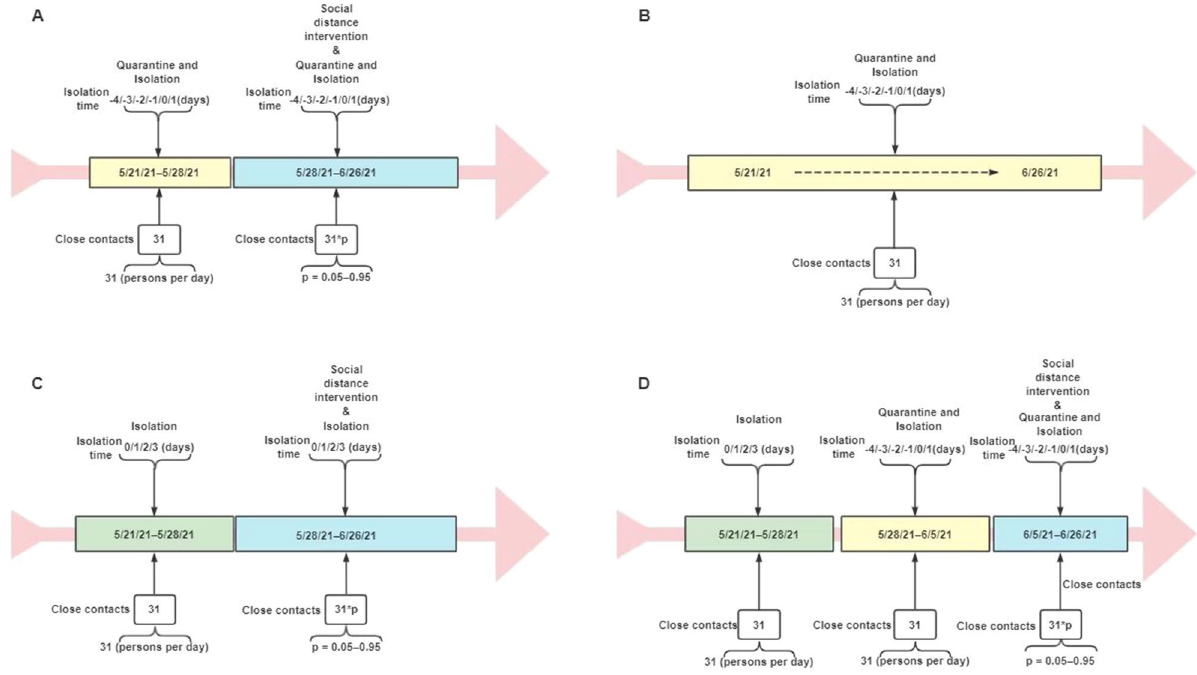
Figure 3. Parameters of the four strategies. ( A ) Strategy 1. Initial quarantine/isolation followed by social distancing. We assumed the time to quarantine/isolation was − 4 to 1 days from May 21 to June 26, owing to mass testing and contact tracing. Considering that the first case was found and the implementations were imposed by government in Guangzhou from May 21, we calculated 31 daily contacts per person in Guangzhou prior to that date as the routine setting. When social distancing was imposed from May 28 to June 26, 2021, we used 31 multiplied by various percentages (5–95%) to indicate the effect of the intervention. ( B ) Strategy 2. Quarantine/isolation only. We assumed the time to quarantine/isolation was − 4 to 1 days and the number of daily contacts per person was 31 from May 21 to June 26. ( C ) Strategy 3. Initial isolation followed by social distancing. Considering that positive cases could not be identified in a timely manner at symptom onset, we assumed that the time to isolation was 0–3 days from May 21 to June 26. When social distancing was adopted from May 28 to June 26, we used 31 multiplied by various percentages (5–95%) as the effect of the intervention, according to stringency. ( D ) Strategy 4. Initial isolation followed by quarantine and social distancing. This strategy was divided into three phases. Isolation was implemented and set to 0–3 days in phase I (May 21–28). Quarantine was imposed in phase II (May 28–June 26) and changed to − 4 to 1 days. Social distancing was implemented in phase III (June 5–June 26); we used 31 daily contacts per person multiplied by different percentages (5–95%) to simulate the effect of these control